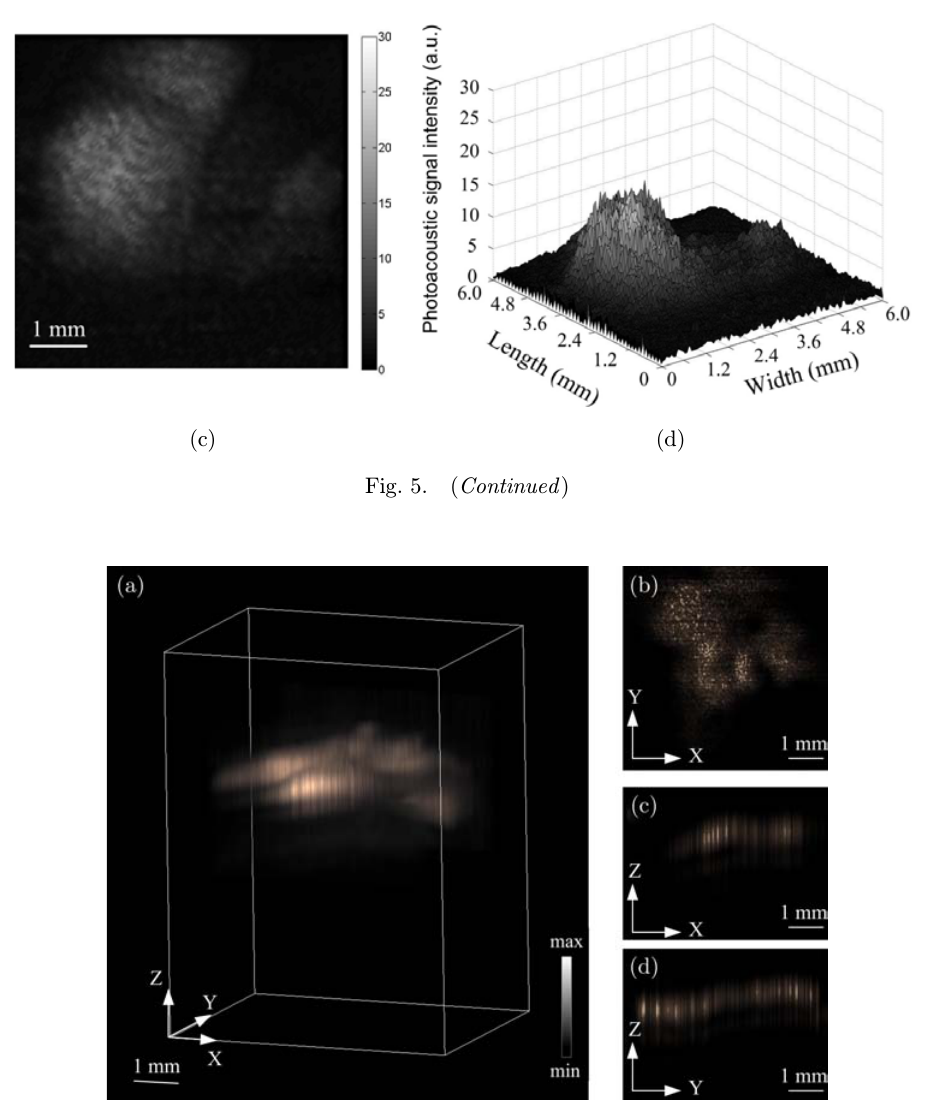
Fig. 6. (a) 3D photoacoustic imaging of ICG (cid:1) PL (cid:1) PEG nanoparticles injected directly into the °ank region of female Balb/c mice, (b) Three slices of two-dimensional photoacoustic images correspond to Fig. 6(a).